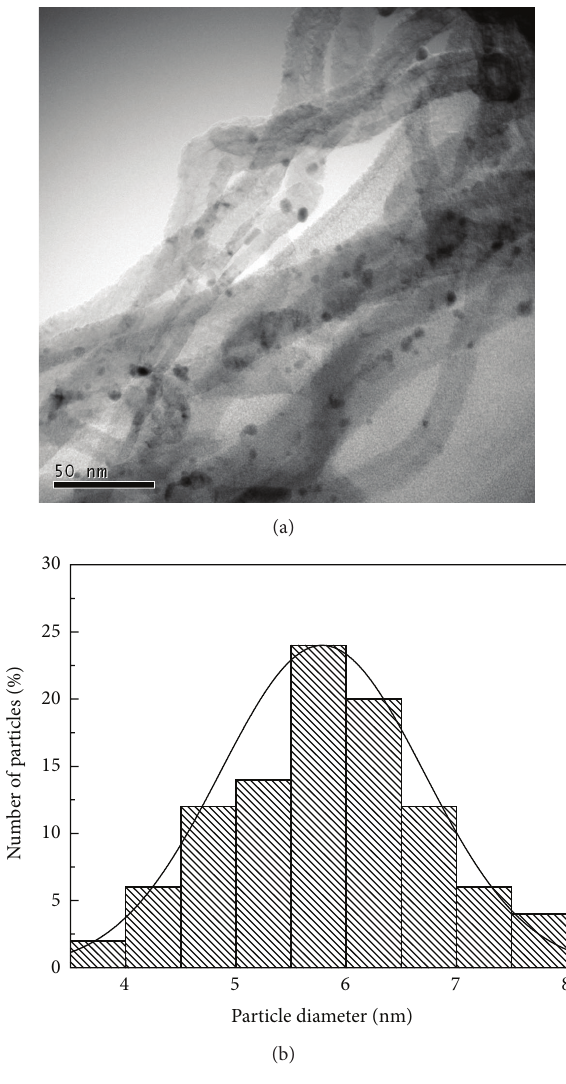
Figure 4: TEM pattern and the particle size of